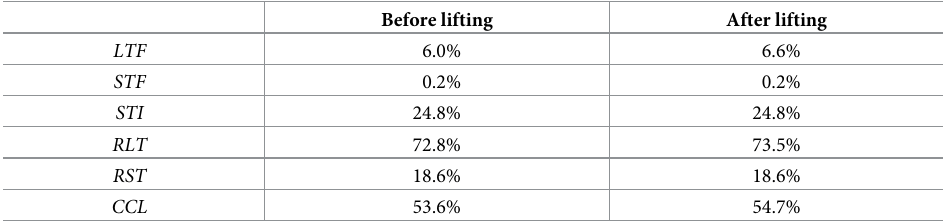
Table 7. Impact of applying the lifting procedure in percentage Pr .